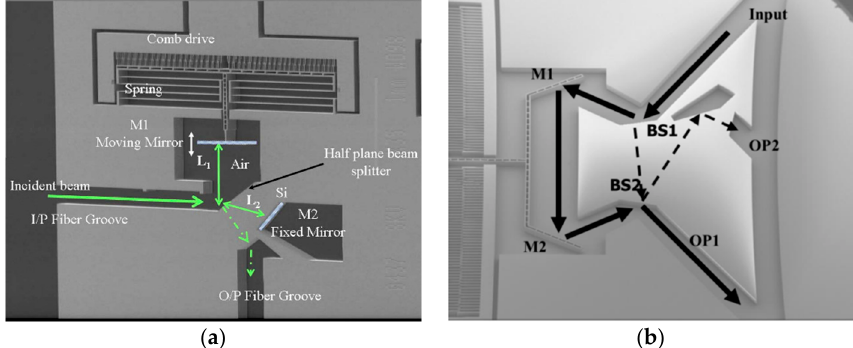
Figure 9. In plane-integrated FTS: ( a ) Classical Michelson interferometer configuration; ( b ) Mach- Zehnder configuration. (Reprinted with permission from Reference [33] SPIE).